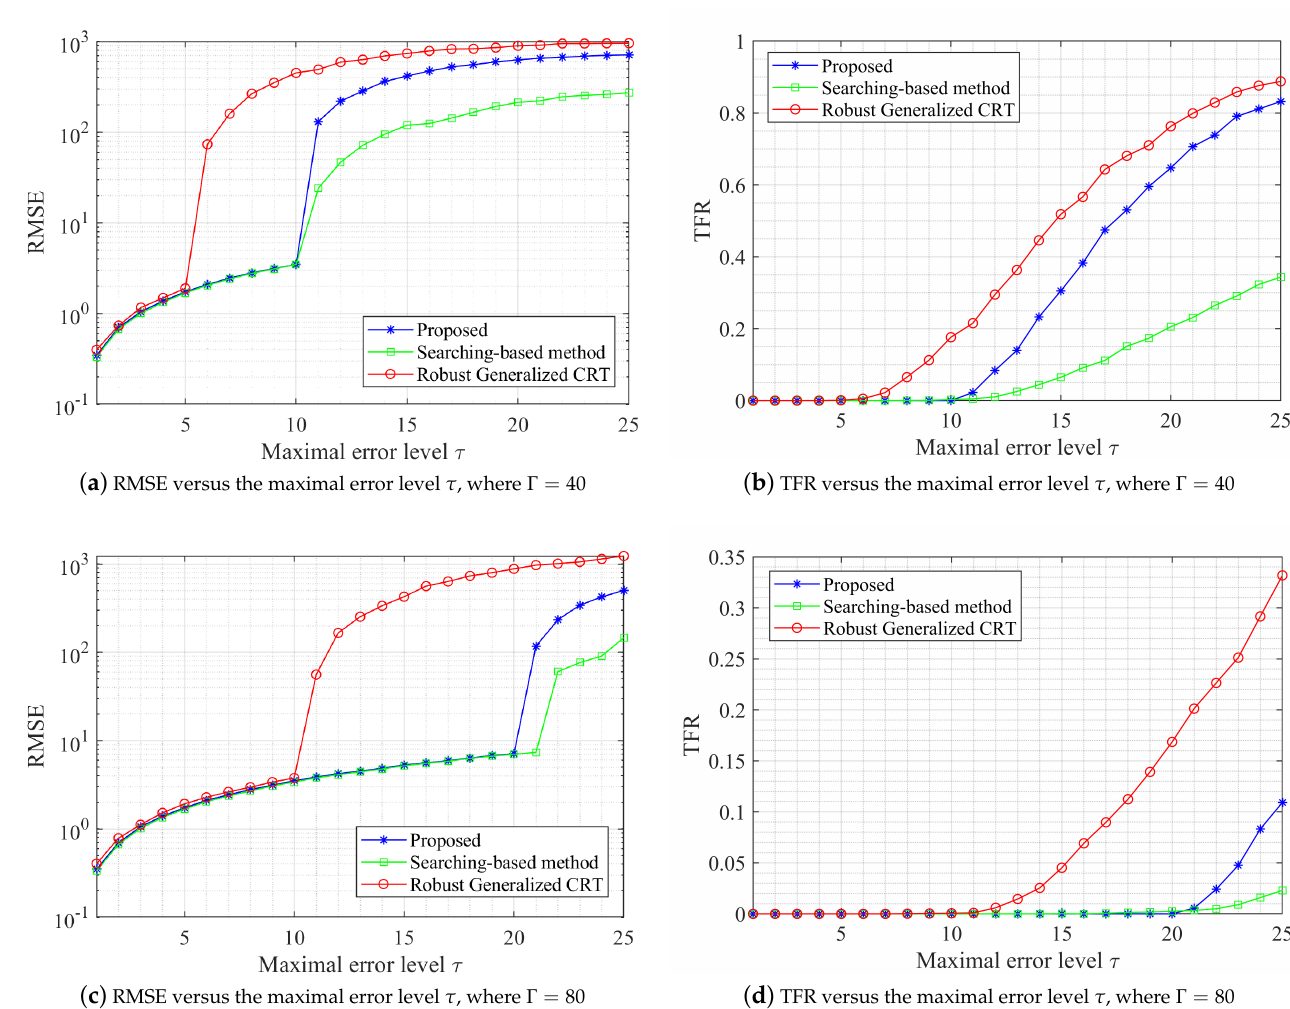
Figure 5. Performance simulation comparison among searching-based method [29], robust general- ized CRT [23] and proposed